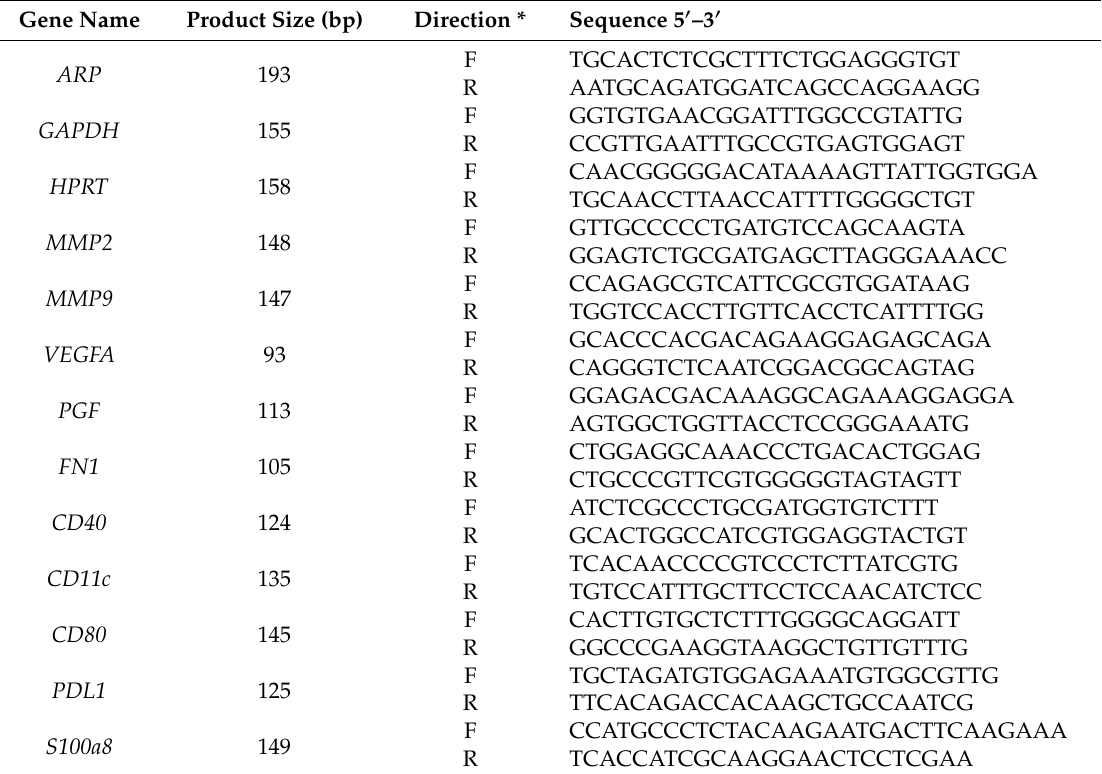
Table A5. PCR primers used in this